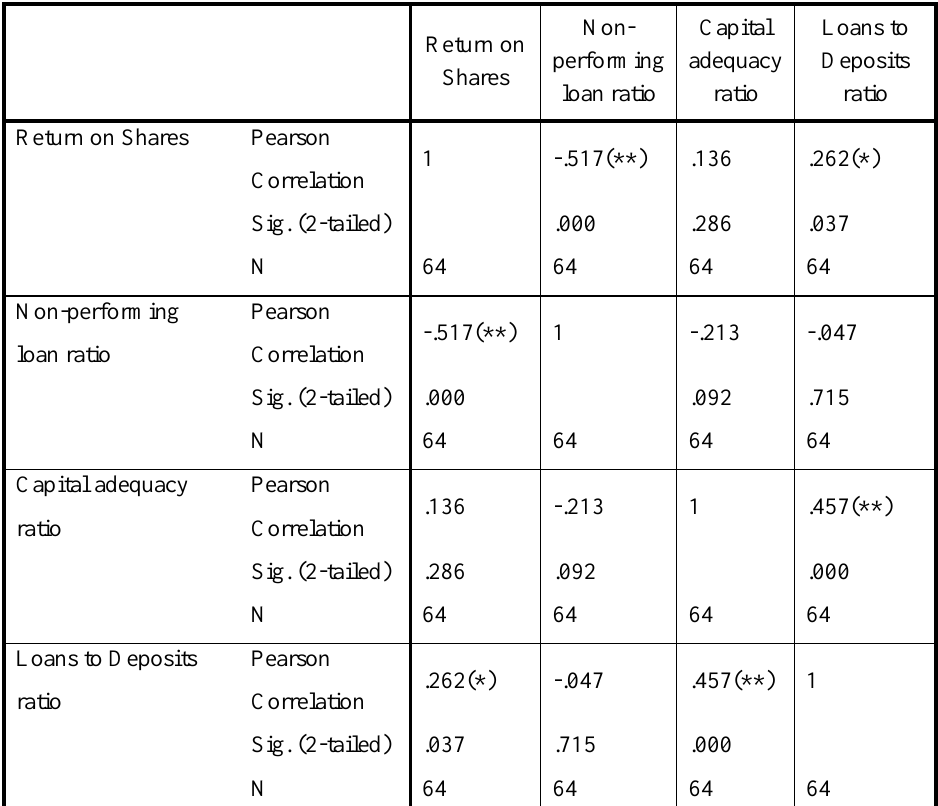
Non- Return on performing Shares loan ratio